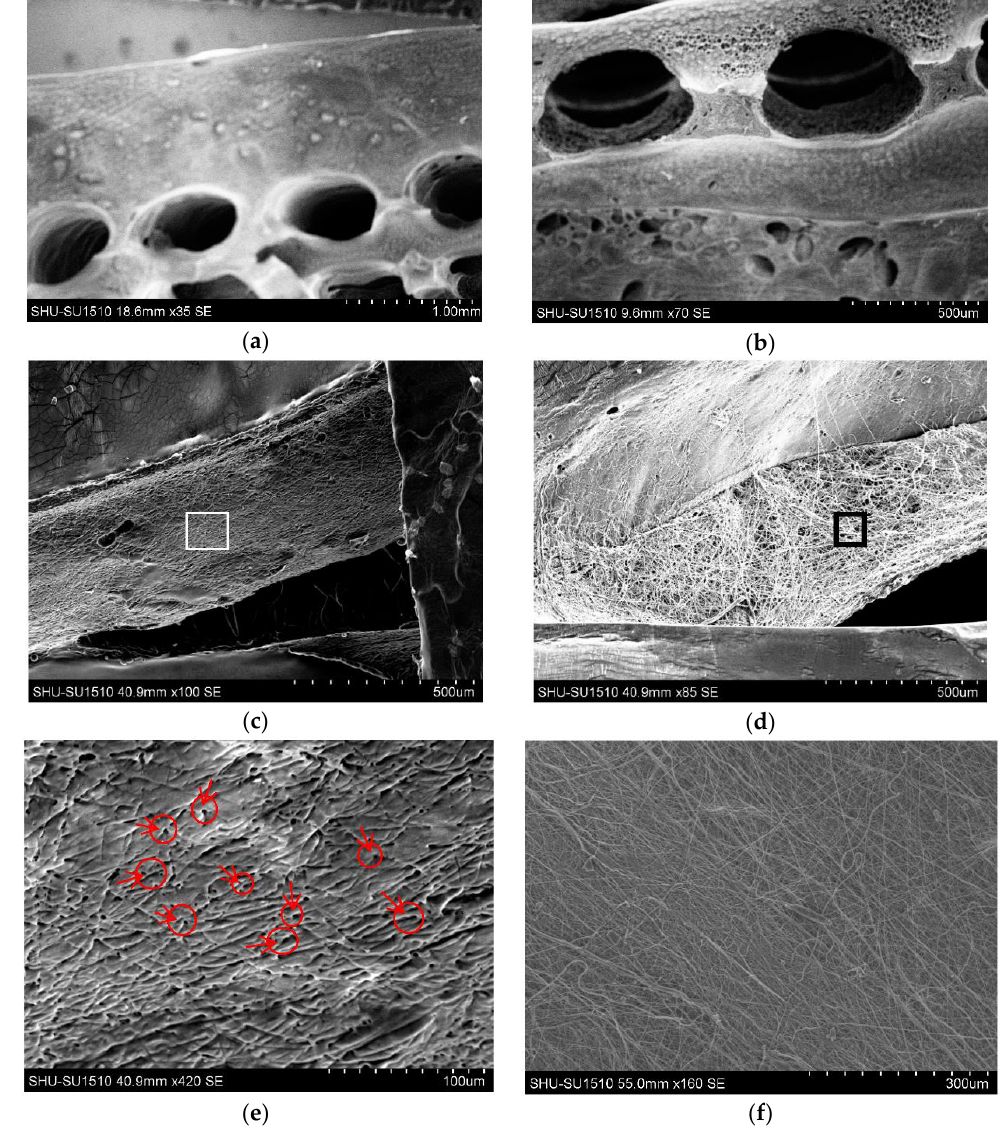
Figure 4. Scanning electron microscope images of the construction. ( a , b ) Orderly macrochannels in the construct; ( c ) section image of Gel-F127-PCL group; ( d ) section image of Gel-PCL group; ( e ) image of partial enlargement of ( c ); and ( f ) image of partial enlargement of ( d ). Red arrows and circles in ( e ) mark some small holes.